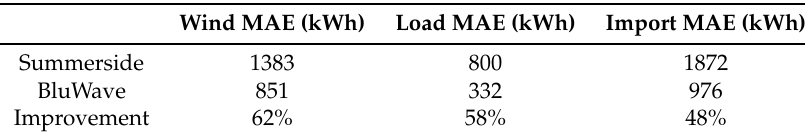
Table 2. Wind, load, and import schedule predictions MAE and comparison.